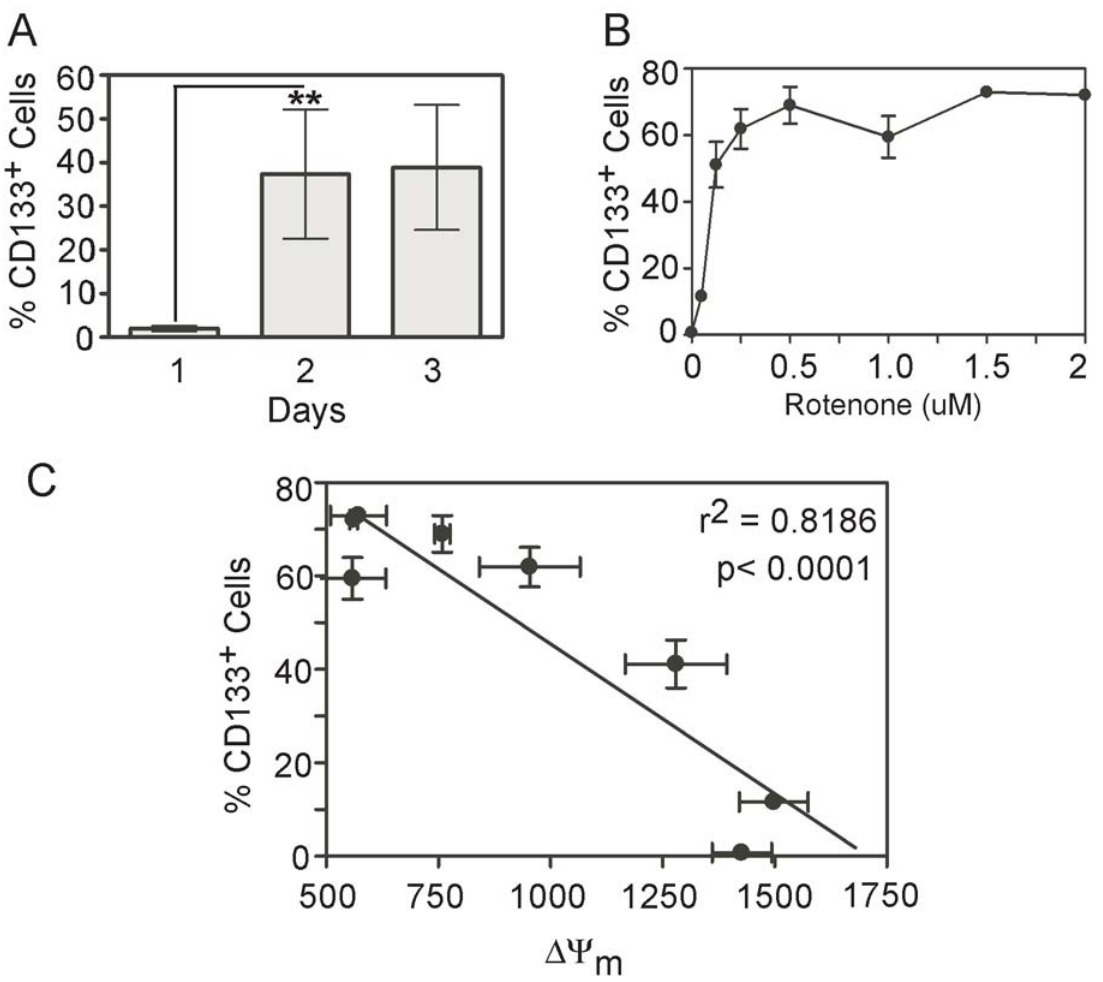
Figure 2. Rotenone enriched the population of CD133 positive glioma cells. A ) Time-dependent expression of CD133 in U251 glioma cells exposed to 1 m M rotenone for up to 3 days. B ) Dose-dependent regulation of CD133 positive cells. C ) Relationship between percentage of CD133 positive cells and DY m. Data were analyzed by linear regression and p value were calculated using Spearman correlation test. Results are given as means 6 SD of 5 separate experiments. ** represent p , 0.001.